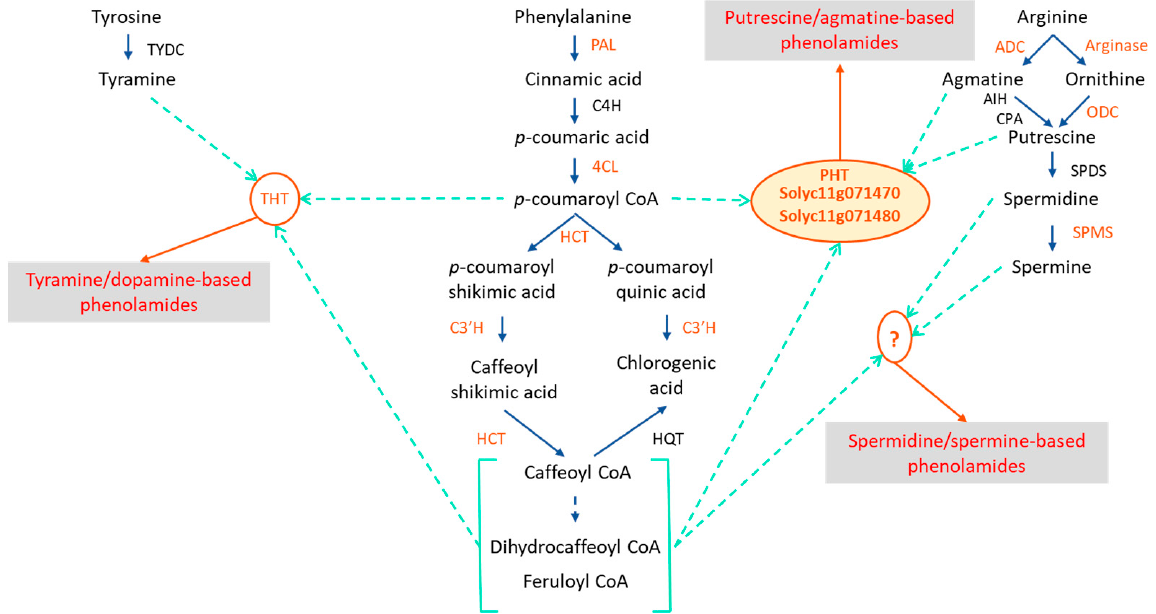
Figure 7. Schematic representation of the main modulations, at the metabolite and transcript levels, of the phenolamide biosynthesis in response to the herbivory of T. absoluta . Genes in orange were shown to be up-regulated upon T. absoluta herbivory through RNAseq and/or qPCR. The three phenolamide categories in red were shown to be over-accumulated upon T. absoluta herbivory. The blue arrows in solid line represent metabolic steps in the phenylpropanoid and polyamine/monoamine pathways. The light-blue arrows in dashed lines connect the phenylpropanoid and polyamine/monoamine substrates to lead to the synthesis of the three categories of phenolamides catalyzed by three types of enzymes, THT, PHT and a yet unknown enzyme. ADC, arginine decarboxylase; ODC, ornithine decarboxylase; SPDS, spermidine synthase; SPMS, spermine synthase; PAL, phe- nylalanine ammonia lyase; C4H, cinnamate-4-hydroxylase; 4CL, 4-coumarate CoEnzyme A ligase; HCT, hydroxycinnamoyl quinate/shikimate hydroxycinnamoyl transferase; C3 ′ H, coumaroyl-3 ′ -hy-